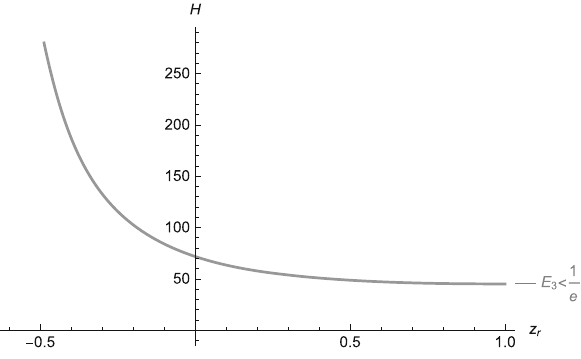
Fig. 28 The graphical nature of H ( z r ) over z r for the cosmological model associated with case III. The free parameters E 5 = 1 . 45, γ = 4 α = 4 > 3 and c = 0 . 0085, E = 0 . 0005 and E 2 1 4